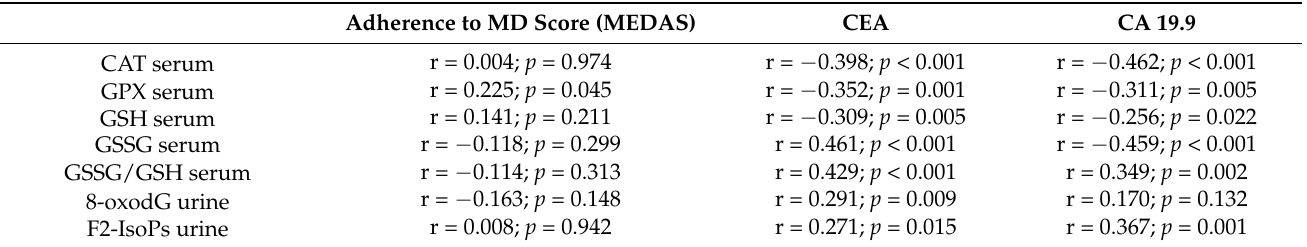
Table 3. Correlation analysis between adherence to the Mediterranean diet, oxidative stress, and tumor